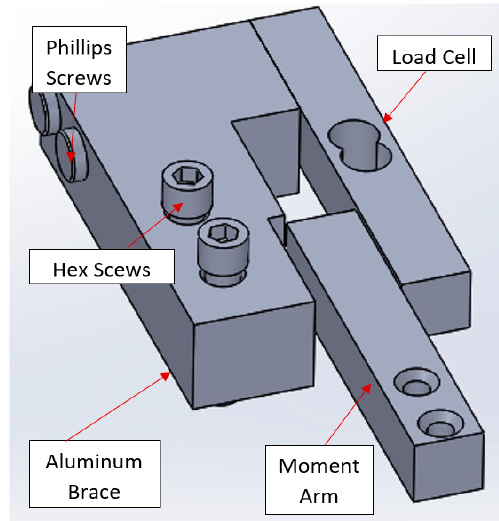
Figure 2. Torque sensor assembly.